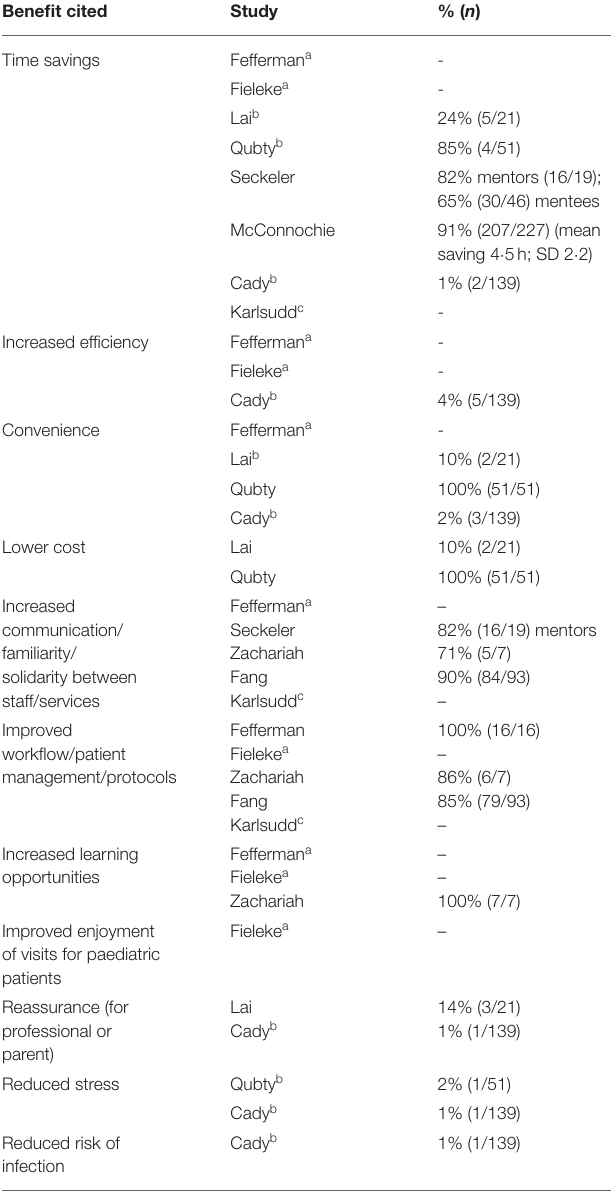
TABLE 4 | Benefits of telemedicine as perceived by participants. Benefit